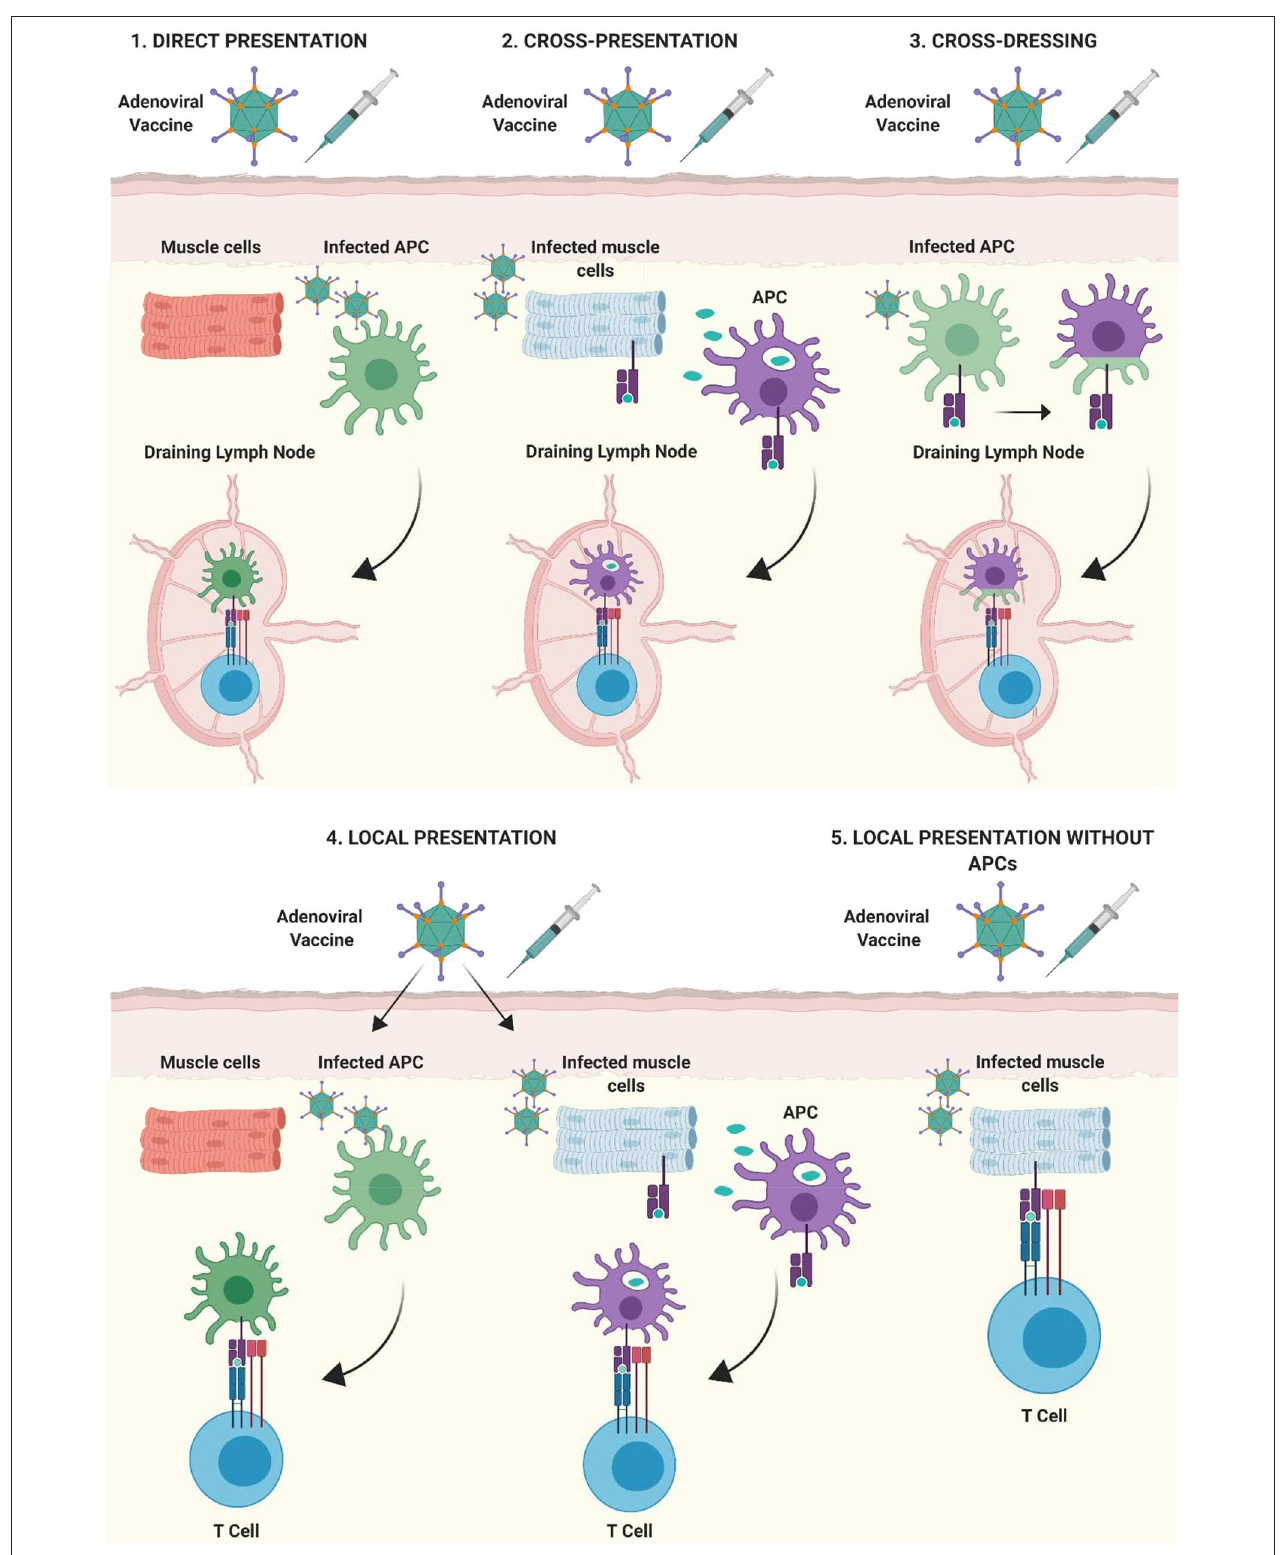
FIGURE 4 | Mechanisms of antigen presentation after intramuscular immunization with adenoviral vectored vaccines. (1) Direct-presentation: Adenoviral vaccine transduces APCs at the site of injection. APCs migrate to draining lymph nodes (dLNs) where they present processed vaccine antigen to T